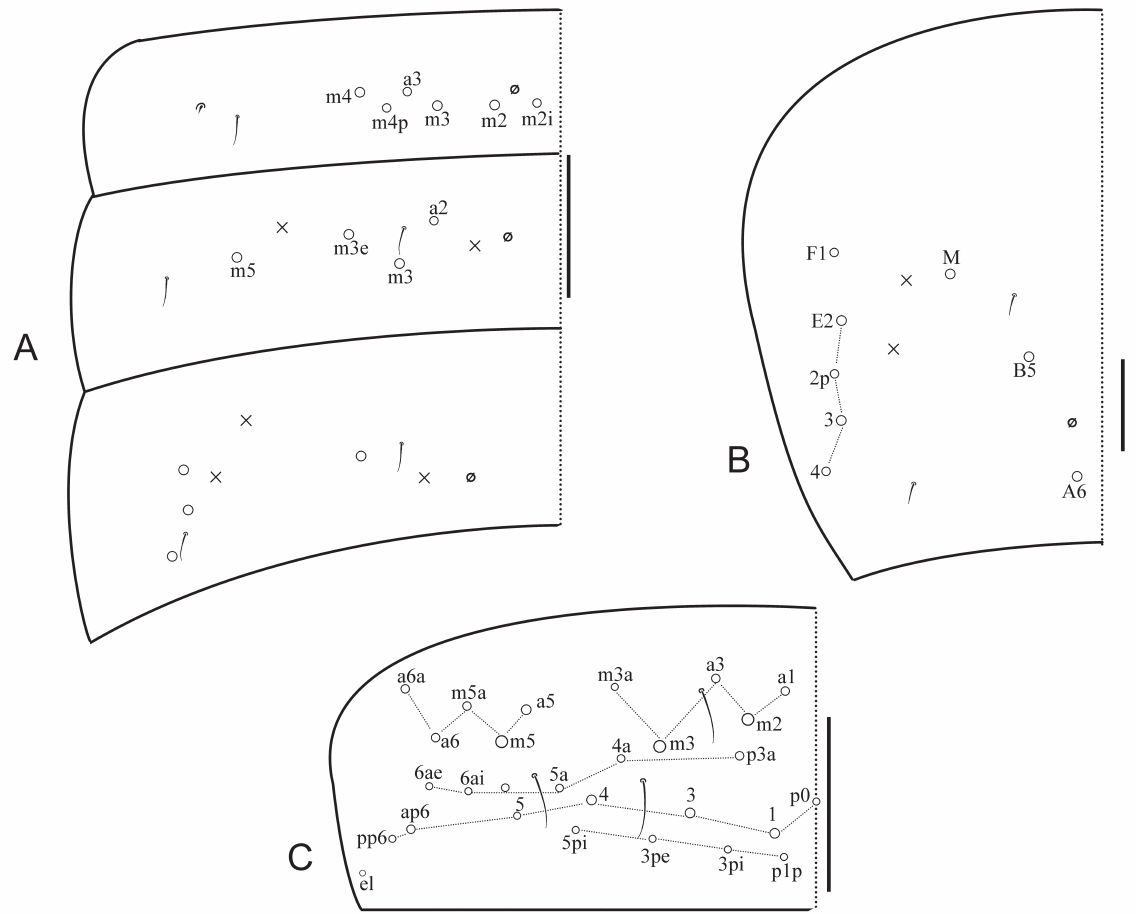
Fig. 7. Abdominal chaetotaxy of Coecobrya ciliata sp. nov. A . Abd. I–III. B . Abd. IV. C . Abd. V. Scale bars: 50